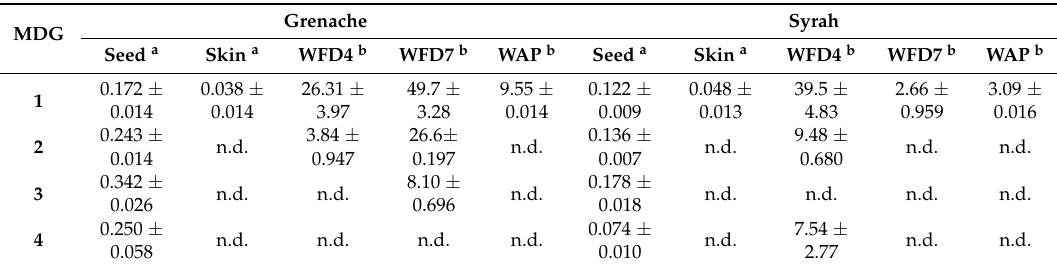
Table 3. Monomeric (epi) catechin diglycoside (MDG) isomers concentrations measured in grape seeds and skins, and during winemaking at WFD4, WFD7, and WAP.